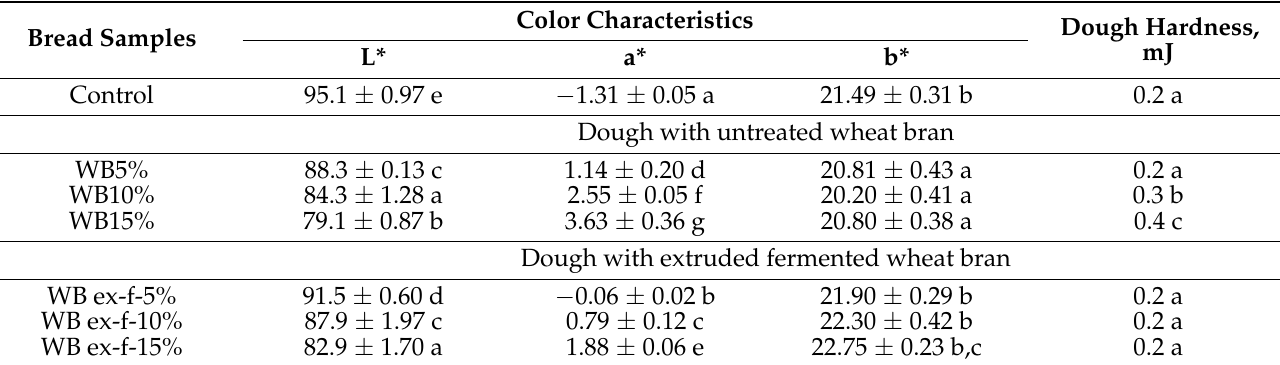
Table 1. Dough color characteristics and